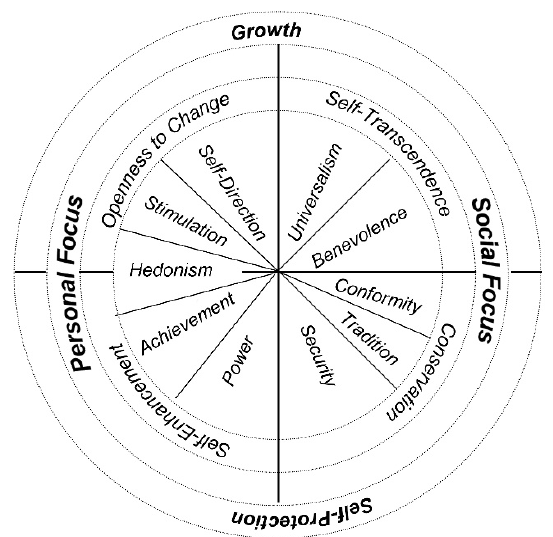
Figure 1. Schwartz quasi-circumplex model of value types and higher order dimensions, adapted from Schwartz (2012).